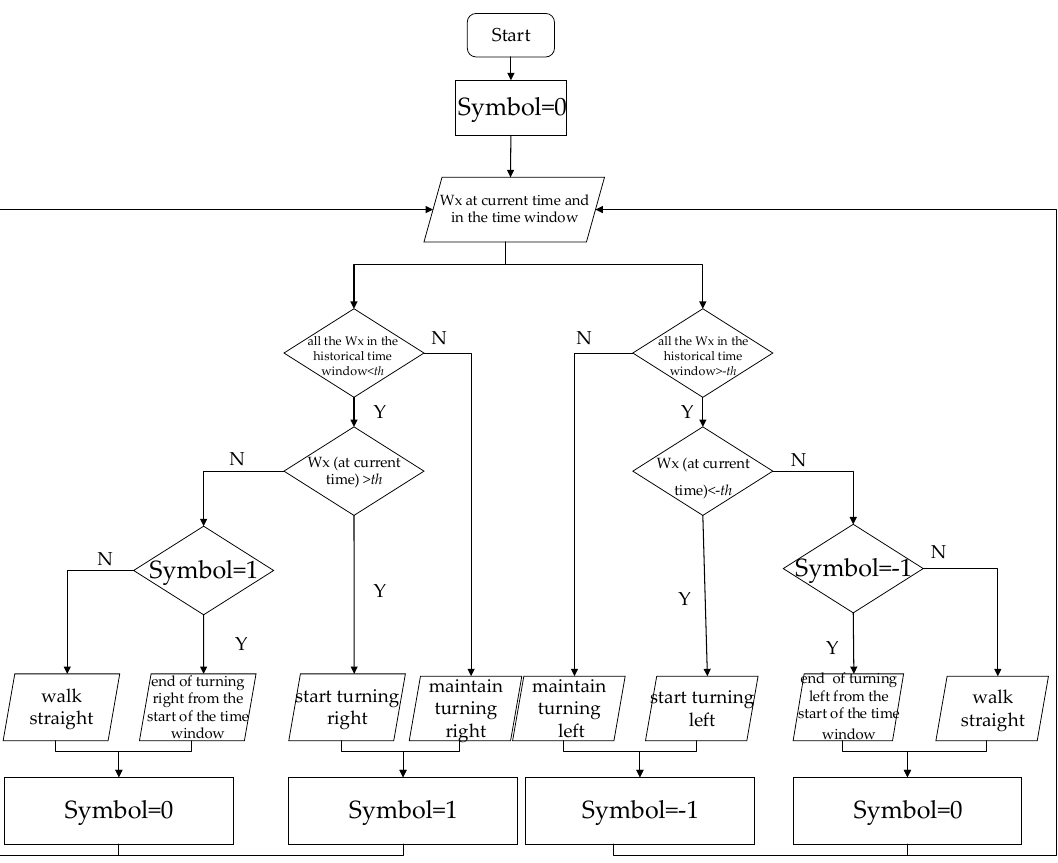
Figure 6. The flow chart of the turn detection algorithm.